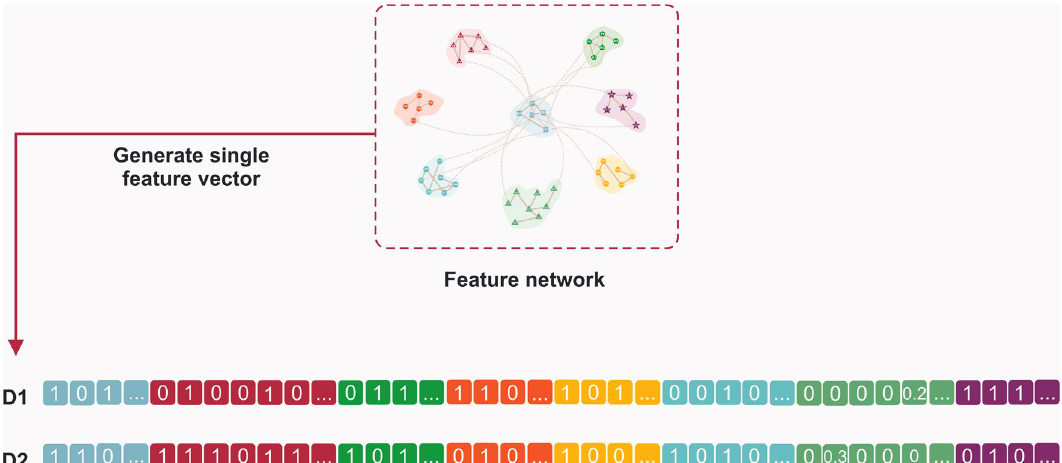
Figure 5. Single input feature vectors. Single input feature vectors derived from multi-topological structural relations among the drug-target, protein–protein interaction, protein-metabolite interaction, gene mutation, gene expression, differential methylation, chemical structures, and cell lines.